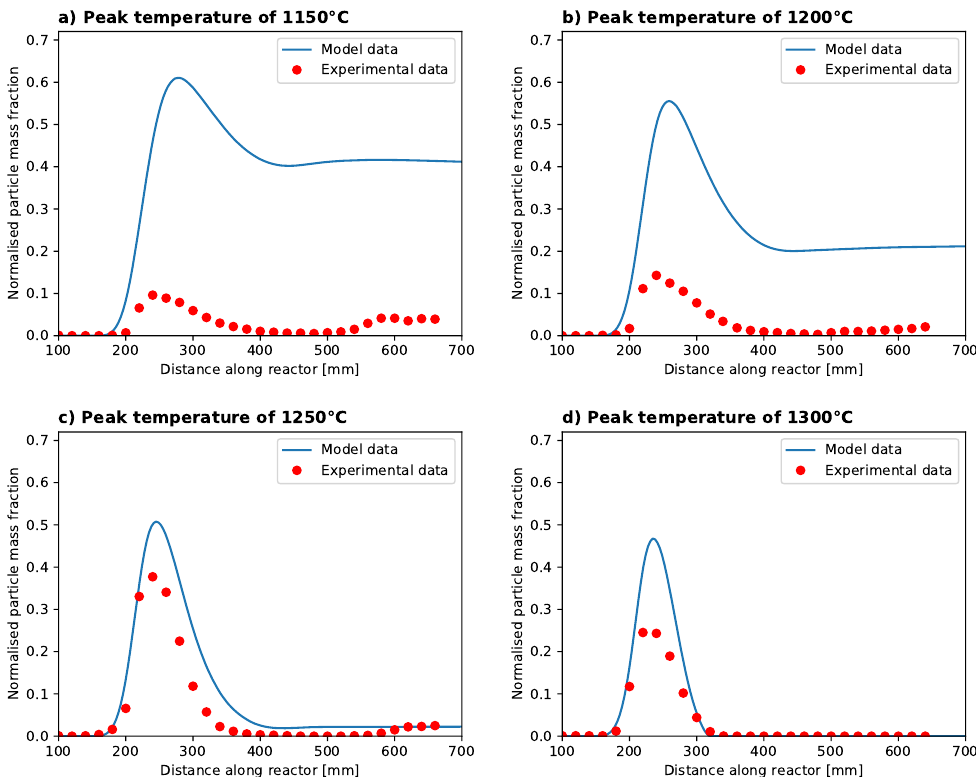
Figure 1. Model data (blue line) compared to experimental measurements by [9] (red circles). The model and experiments use a flowrate of 0.5lmin − 1 and ferrocene mass fraction of 0.5mass%: ( a ) a peak temperature of 1150 ◦ C; ( b ) a peak temperature of 1200 ◦ C; ( c ) a peak temperature of 1250 ◦ C; and ( d ) a peak temperature of 1300 ◦